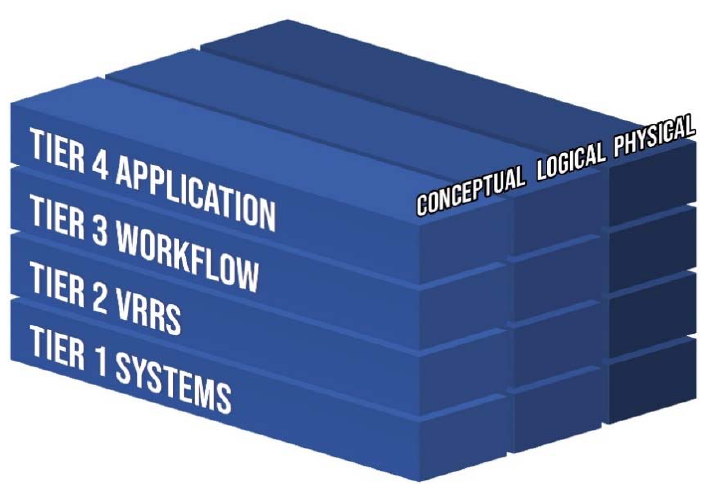
Figure 1. MOESIR four-tier ontological and epistemological framework for decision support systems implementation abstraction. Four tiers of software systems components are each expressed in terms of conceptual, logical, and physical levels of abstraction for comprehensive elucidation. This research focuses on the Tier 2 conceptual level.